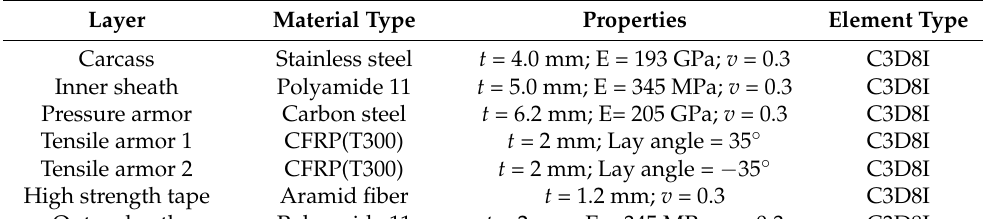
Table 5. Characteristics of the analyzed 4-inch (101.6 mm) flexible pipe.